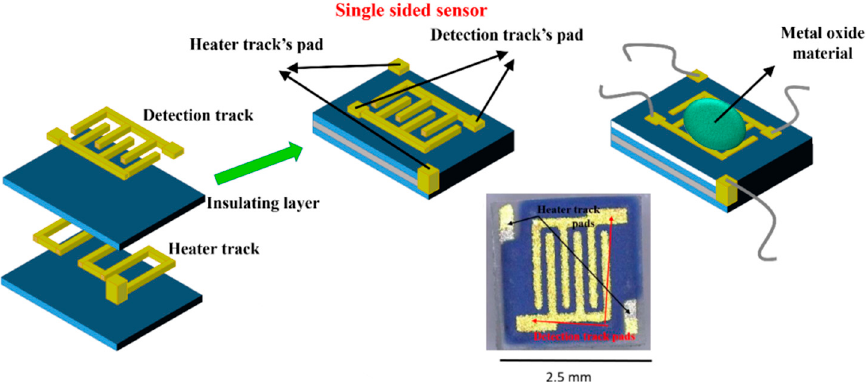
Figure 2. Substrate construction and photo of final device.